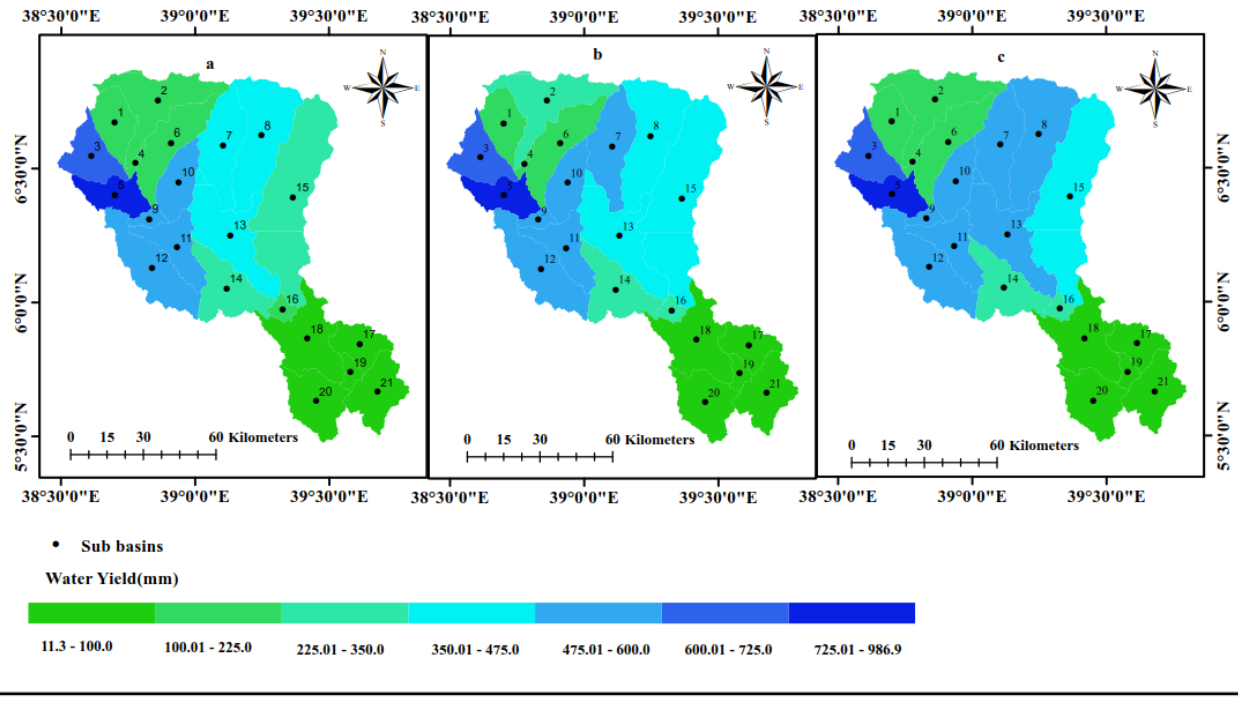
Figure 11. Simulated spatial distribution of water yield for ( a ) 1986, ( b ) 2001 and ( c ) 2016 LULC.